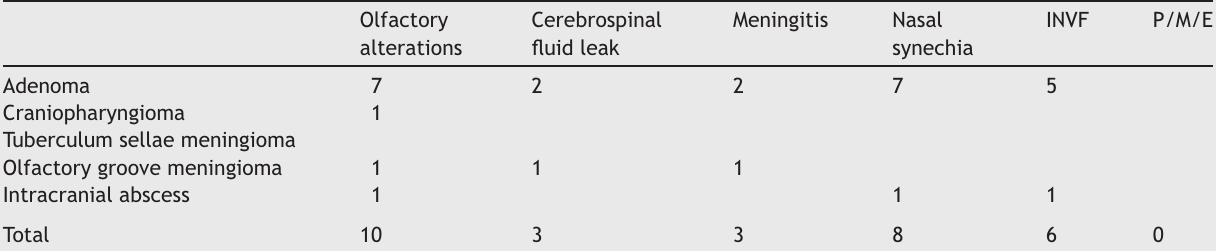
Complications from endonasal endoscopic surgery of the skull base, per disease.